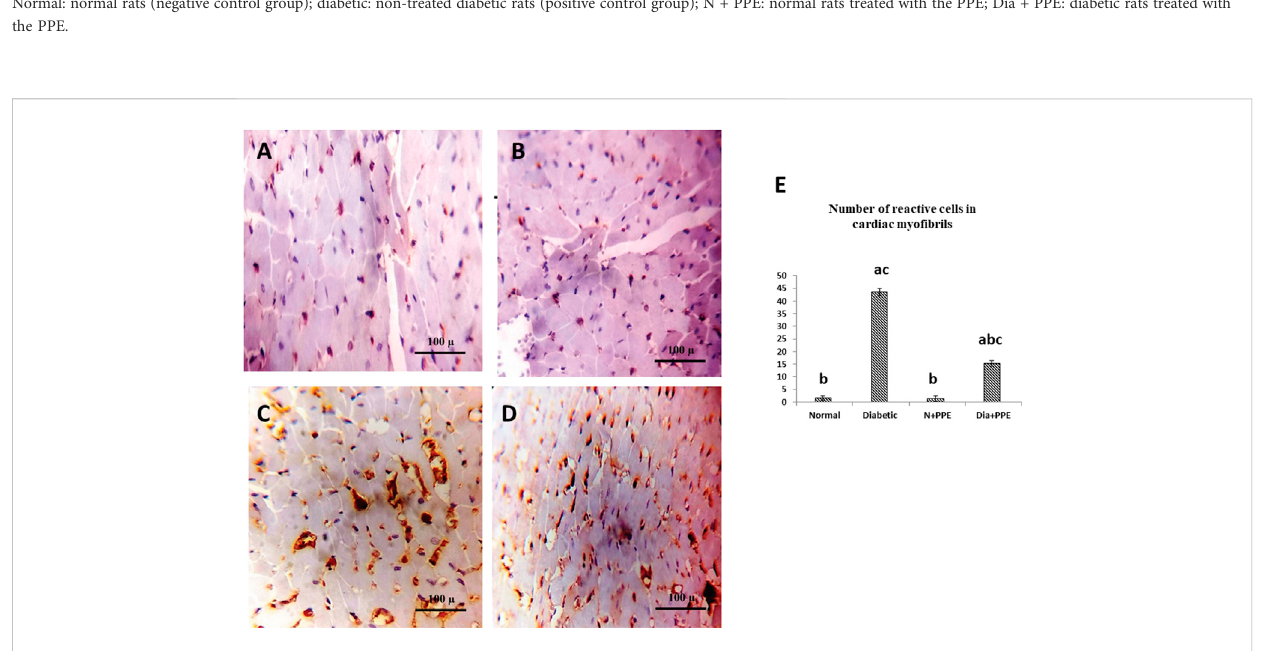
FIGURE 6 Immunostained cardiac myo fi brils against TGF- β . (A) Non-diabetic rats in the negative control group cardiac wall showing negative cell membrane reactivityincardiacmyo fi brils. (B) Cardiacwallofnon-diabeticratstreatedwiththepomegranatepeelextractshowingnegativecellmembranereactivity in cardiac myo fi brils. (C) Cardiac wall of the diabetic rats in the positive control group showing marked cell membrane reactivity in cardiac myo fi brils. (D) Cardiac wall of the diabetic rats treated with the pomegranate peel extract showing weak cell membrane reactivity in cardiac myo fi brils. (E) Illustrative fi gure demonstrating the average number of reactive cells in cardiac myo fi brils against TGF- β of the studied rat groups. Data are presented as mean± SD; n = 6.Normal:normalrats(negativecontrol group). Diabetic:non-treated diabetic rats(positivecontrol group). N+ PPE: normal rats treated with the PPE. Dia + PPE: diabetic rats treated with the PPE. a: signi fi cant versus negative control group; b: signi fi cant versus positive control group, c: signi fi cant versus treated normal group; p <